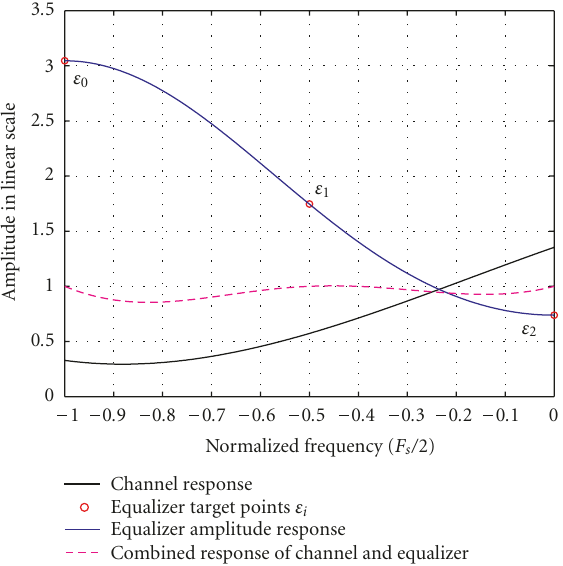
Figure 6: Operation of the ZF-optimized Case 3 amplitude equal- izer section.